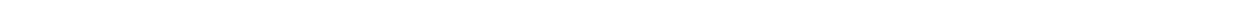
Fig. 10 Activation of ACC-spinal cord projecting neurons contributed to mechanical pain sensitization. a Photos showing the CAV2-cre injection sites in bilateral spinal dorsal horns (left) and the CAV2-cre infected neurons in both sides of the ACC (middle) in Ai32 mice. Diagram showing the optic cannula implantation in the middle side of the ACC. Bars equal to 200 μ m. b Schematics showing the timeline of experiments for CAV2-cre injection into the spinal cord, optic cannula implantation into the ACC, and behavioral test in Ai32 mice. c The procedure for optogenetic modulation during the mechanical pain threshold test. Blue light stimuli (470 nm, 20 Hz) were delivered during the “ on ” session and repeated for 3 time with 1 min intervals. d Blue light stimulation reduced the paw withdrawal threshold in both left and right hind paws of Ai32 ( + cre) but not Ai32 ( − cre) mice. e Schematics showing the timeline of experiments in Ai35 mice. f The procedure for optogenetic modulation during the mechanical pain threshold test. Yellow light stimuli (590 nm) were delivered continuously during the “ on ” session and repeated for 2 time with 3 min interval. g Yellow light stimulation had no effect on the